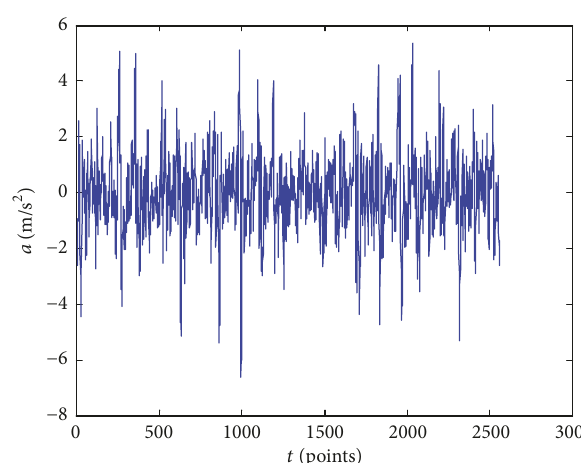
Figure 13: The signal of